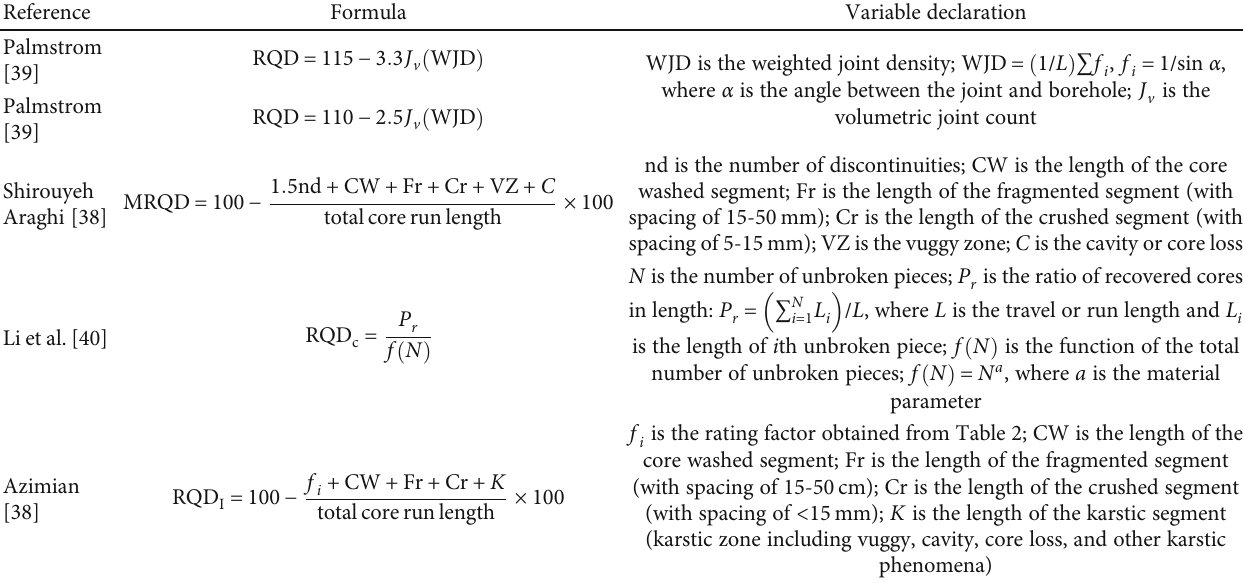
Table 1: Selected expressions of RQD.